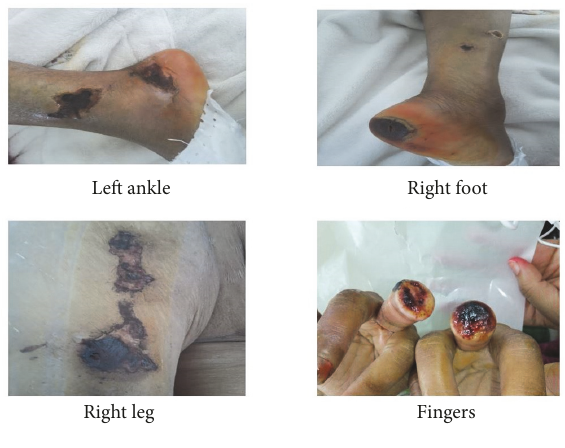
Figure 1: Topography and aspect of Calciphylaxis lesions of patient